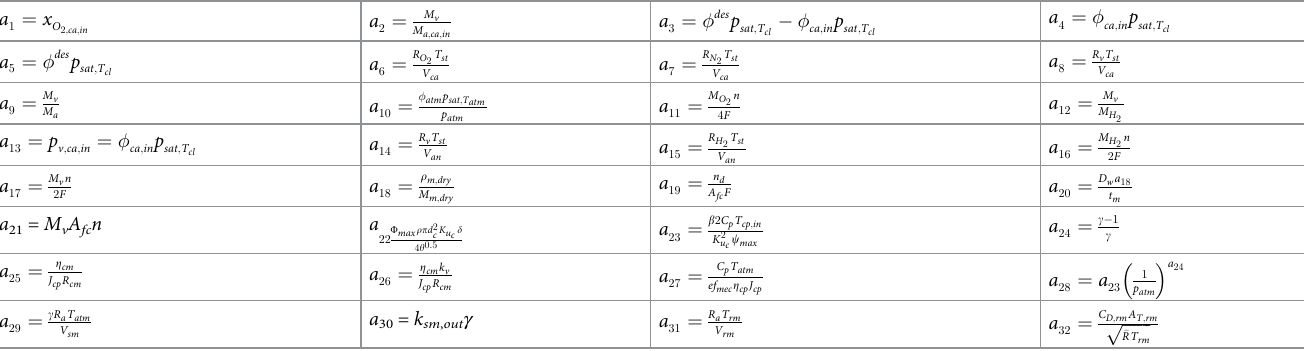
Table 3. Coefficients defined in the fuel cell.